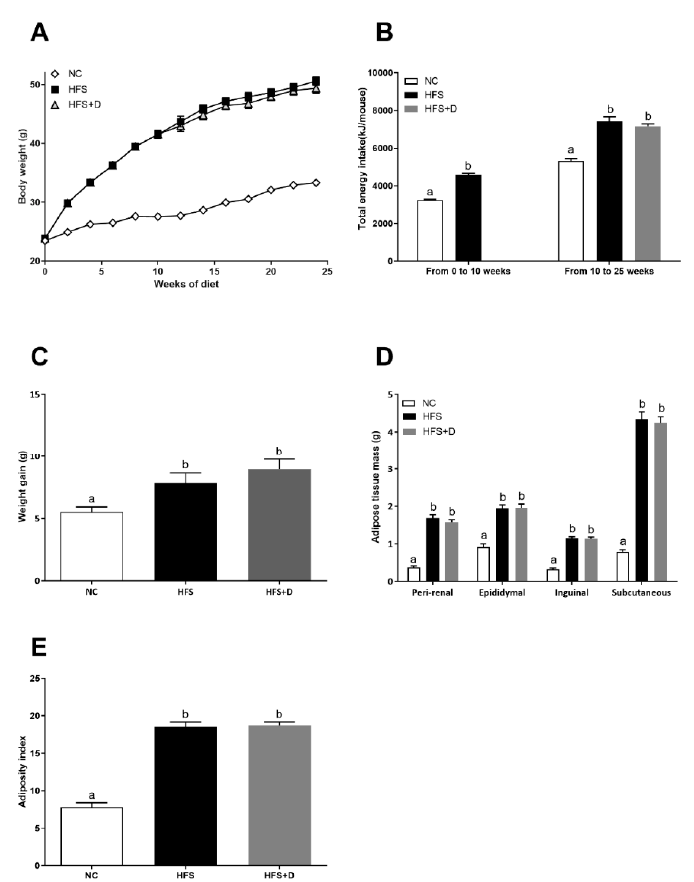
Figure 1. Morphological parameters of mice fed with high-fat / high-sucrose diet and vitamin D supplementation. ( A ) Body weight evolution curve of mice fed with a controlled diet (NC), high-fat / high-sucrose diet (HFS) during the first 10 weeks and then supplemented with vitamin D over a 15-week period (HFS + D). ( B ) The energy intake was quantified by measuring food intake and sucrose water every day for a period of 25 weeks following respective diet consumption. ( C ) Animal weight gain was established; it corresponds to the di ff erence between the body weight at end of the protocol (25th week) and the body weight at the end of the 10-week HFS diet. ( D ) During the sacrifice, adipose tissues were weighed, and body composition was expressed in terms of adipose tissues’ absolute mass. ( E ) An adiposity index was calculated by calculating the ratio between the sum of perirenal, epididymal, inguinal, and subcutaneous adipose masses and body weight; values are presented as means ± SEM; values not sharing the same letter were significantly di ff erent, p <